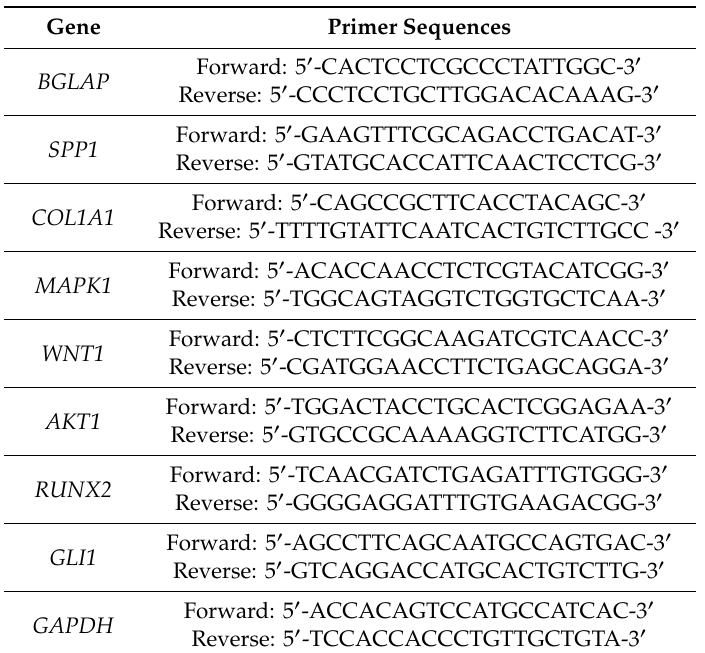
Table 1. List of primer